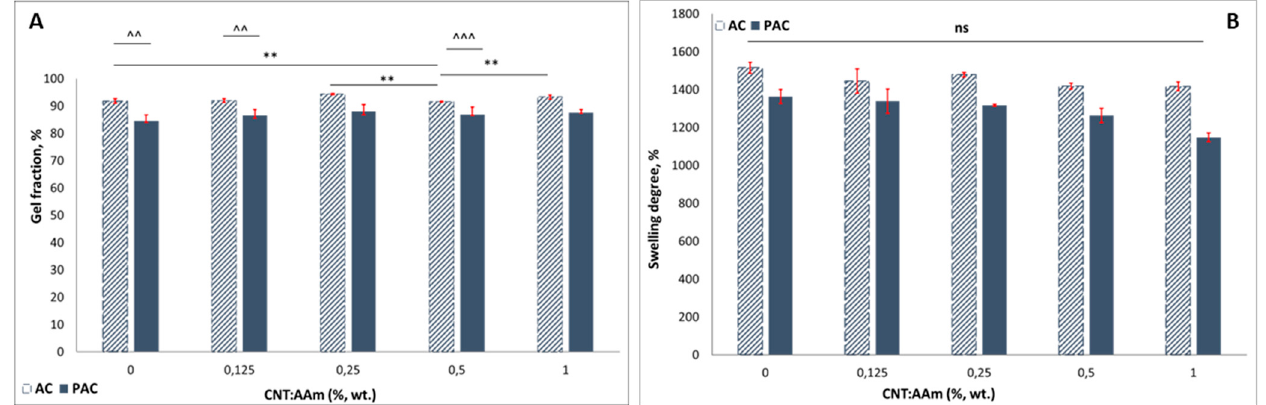
Figure 2. Gel fraction ( A ) and swelling degree ( B ) values computed for the AC (patterned columns) and PAC (full color columns) series. Statistical significance: ^^, ** p < 0.01, ^^^ p < 0.001, ns—not statistically significant.